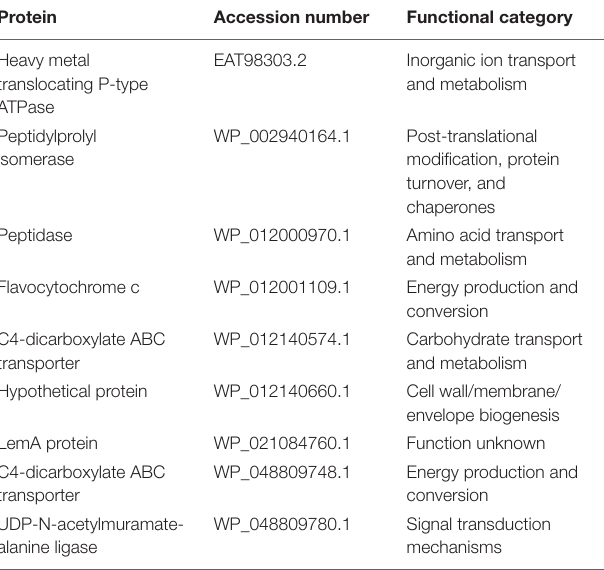
( Table 4 ). When C. concisus was cultured on HBA fum0 . 4 , there were 27 unique proteins identified ( Table 5